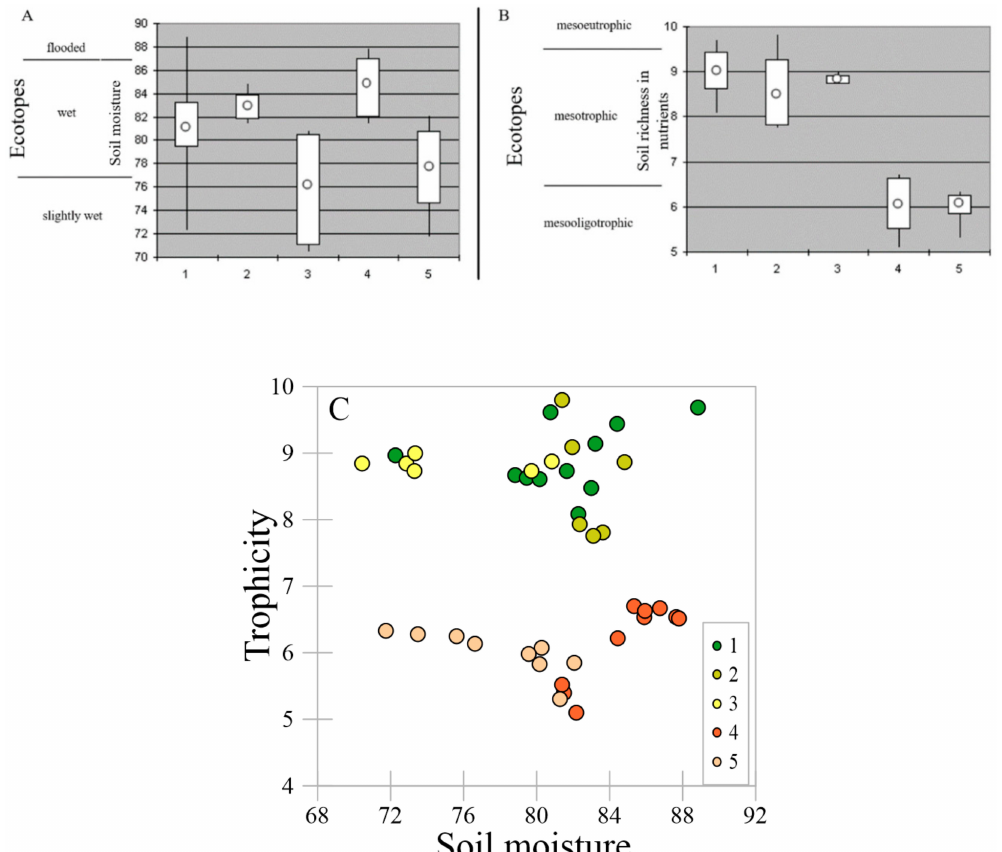
Figure A1. Scattering of the studied ecotopes based on the soil nutrient richness and moisture (for Tsatsenkin’s indicator values). ( A )—moisture: ( B )—soil richness in nutrients. ( C )—all studied sites with descriptions of plant communities. 1—early stage; 2—mid stage (fen); 3—mid stage (mound); 4—late stage (fen); 5—late stage (mound).